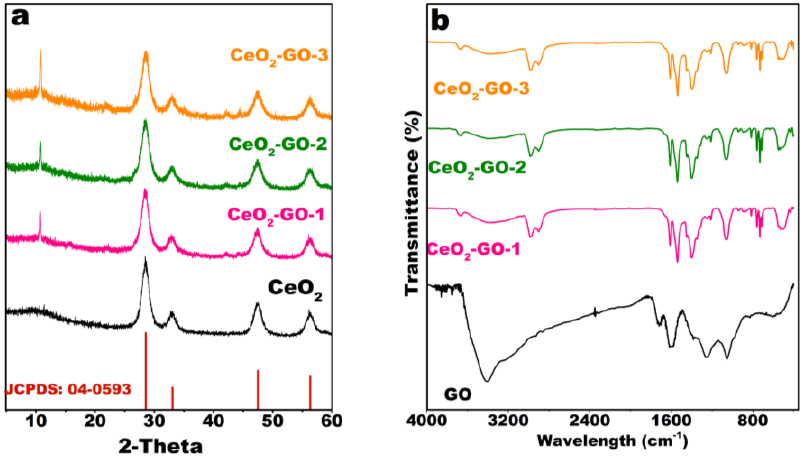
Figure 1. ( a ) XRD pattern and ( b ) FT−IR spectra of the electrocatalysts.